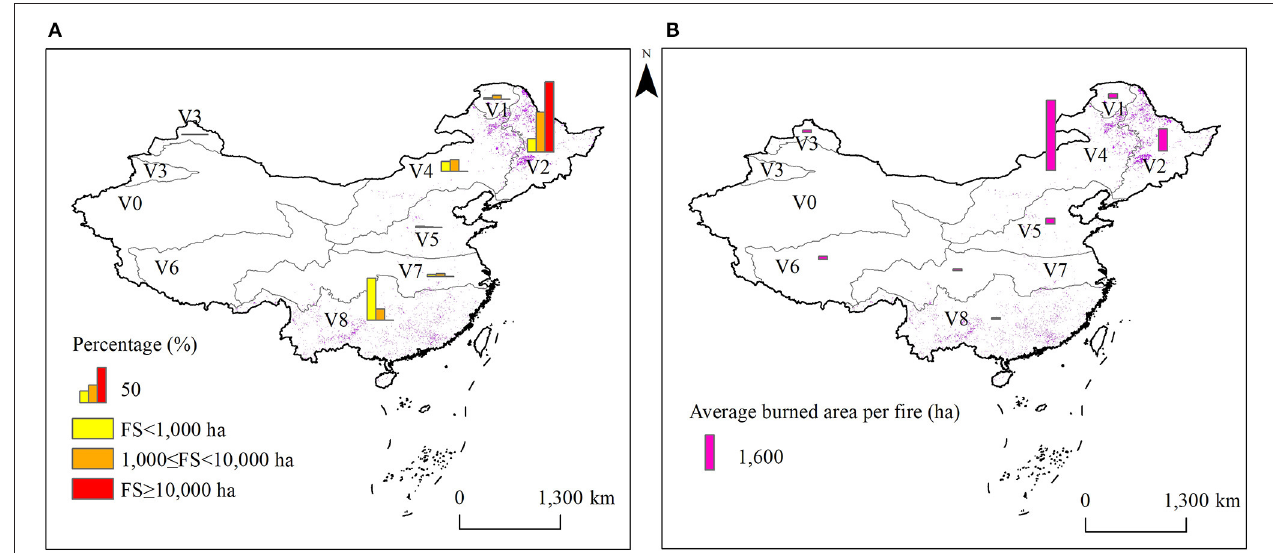
FIGURE 4 | Percentage of fires in different fire size classes. (A) percentage of fires with different fire size; (B) average burned area per fire.